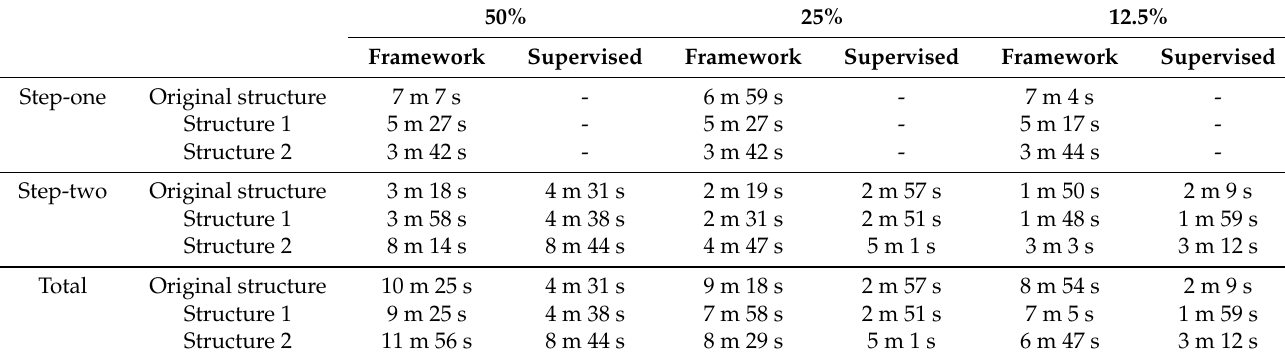
Supervised Framework Supervised